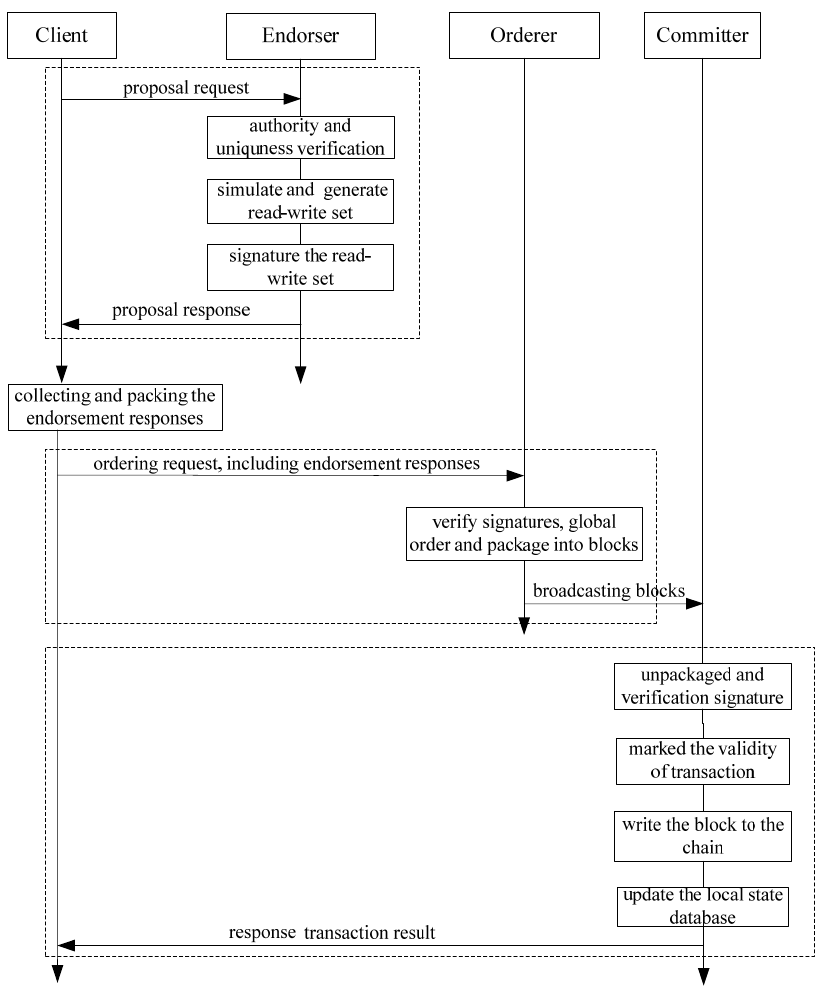
Figure 1. The flow of specific Fabric transaction processing.